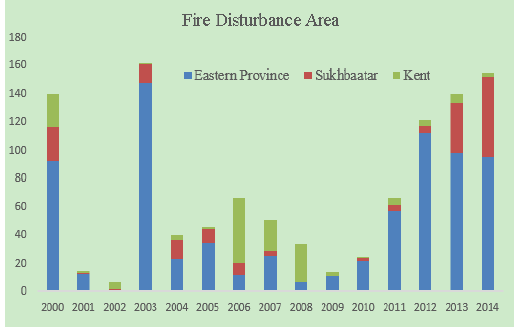
Figure 3. The Seasonal (a) Distribution of Fires